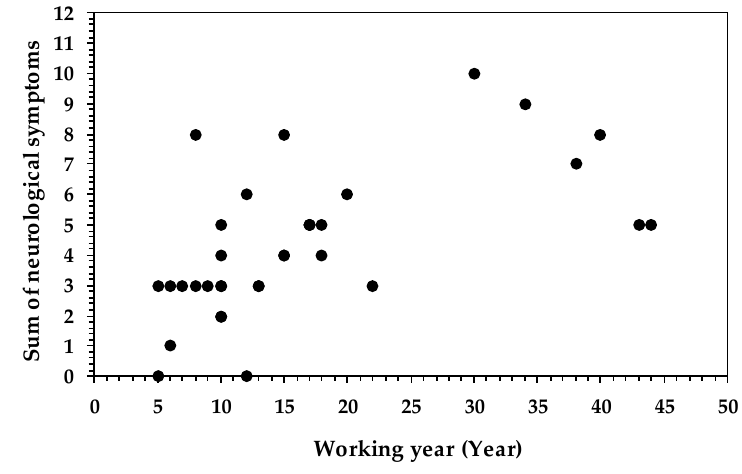
Figure 5. Relationships between working year and the sum of neurological symptoms.